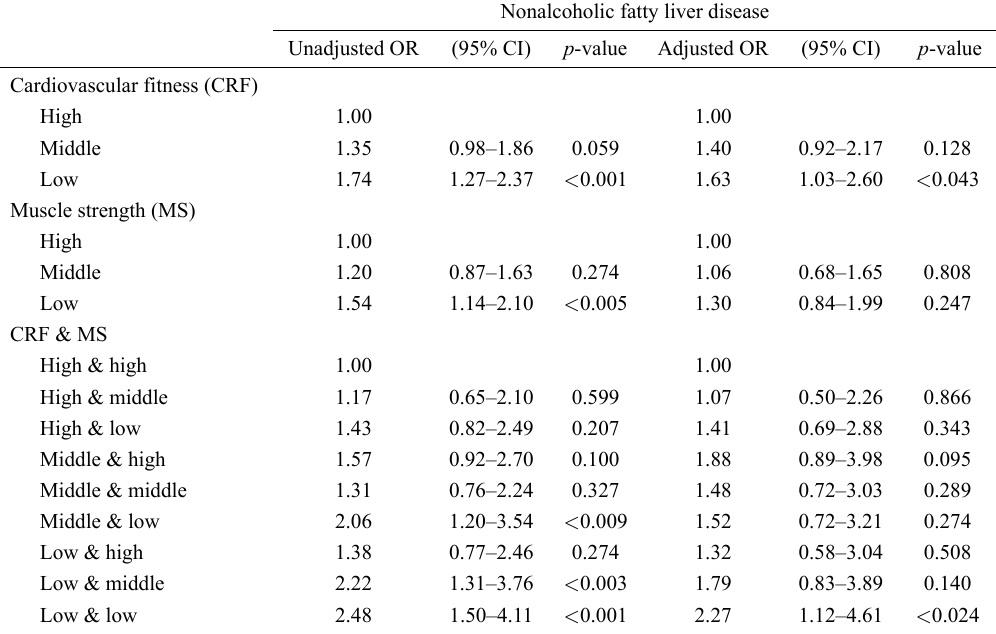
Table 4. Odds ratio of NAFLD in accordance with cardiovascular fitness and muscle strength